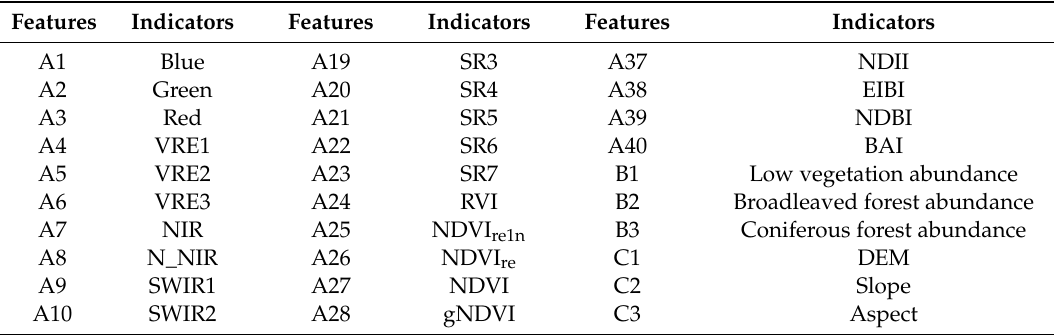
Table 1. Potential features for classification and their